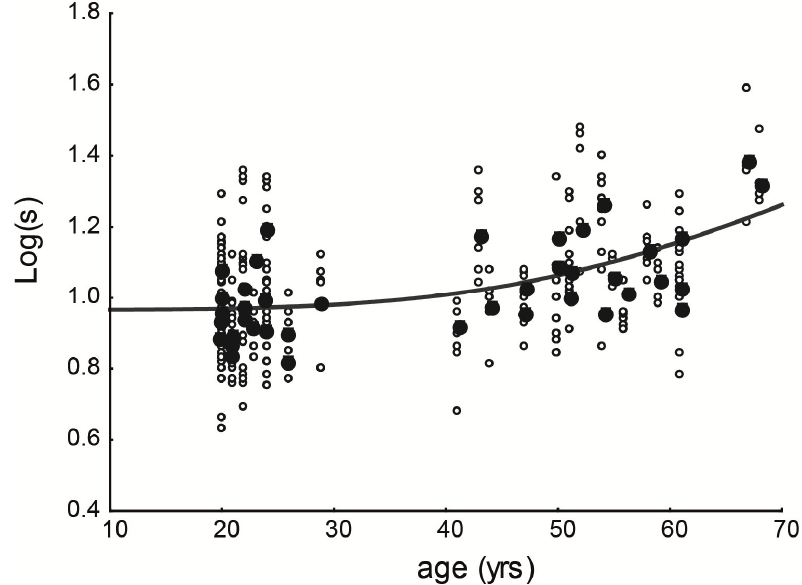
Figure 3. Straylight values from both groups. Dark-grey line indicates the function adjusted to the data: Log( s ) = log(9.25 × (1 + (age/70.35) 4 )).